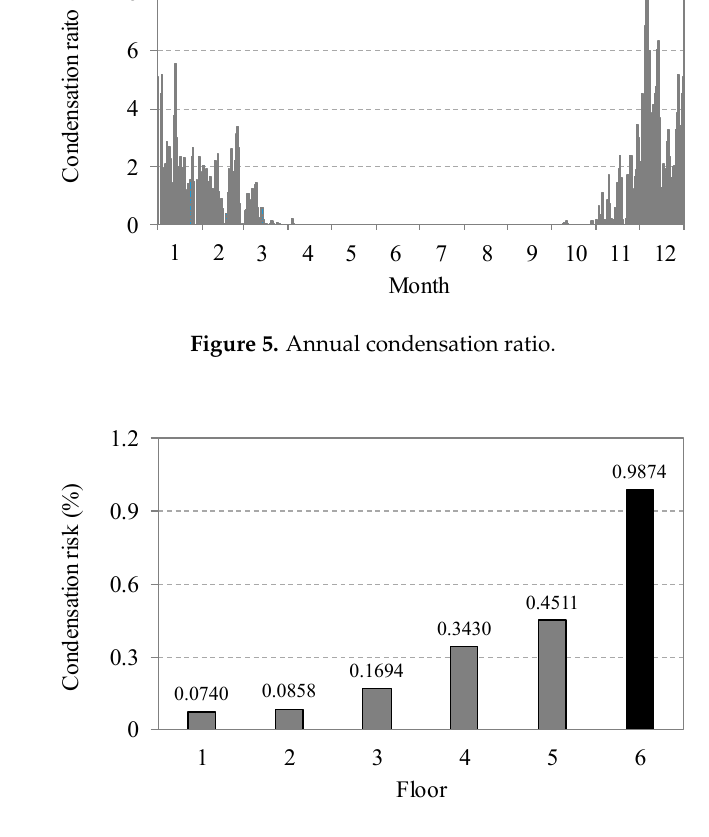
Figure 6. Condensation risk for each floor.